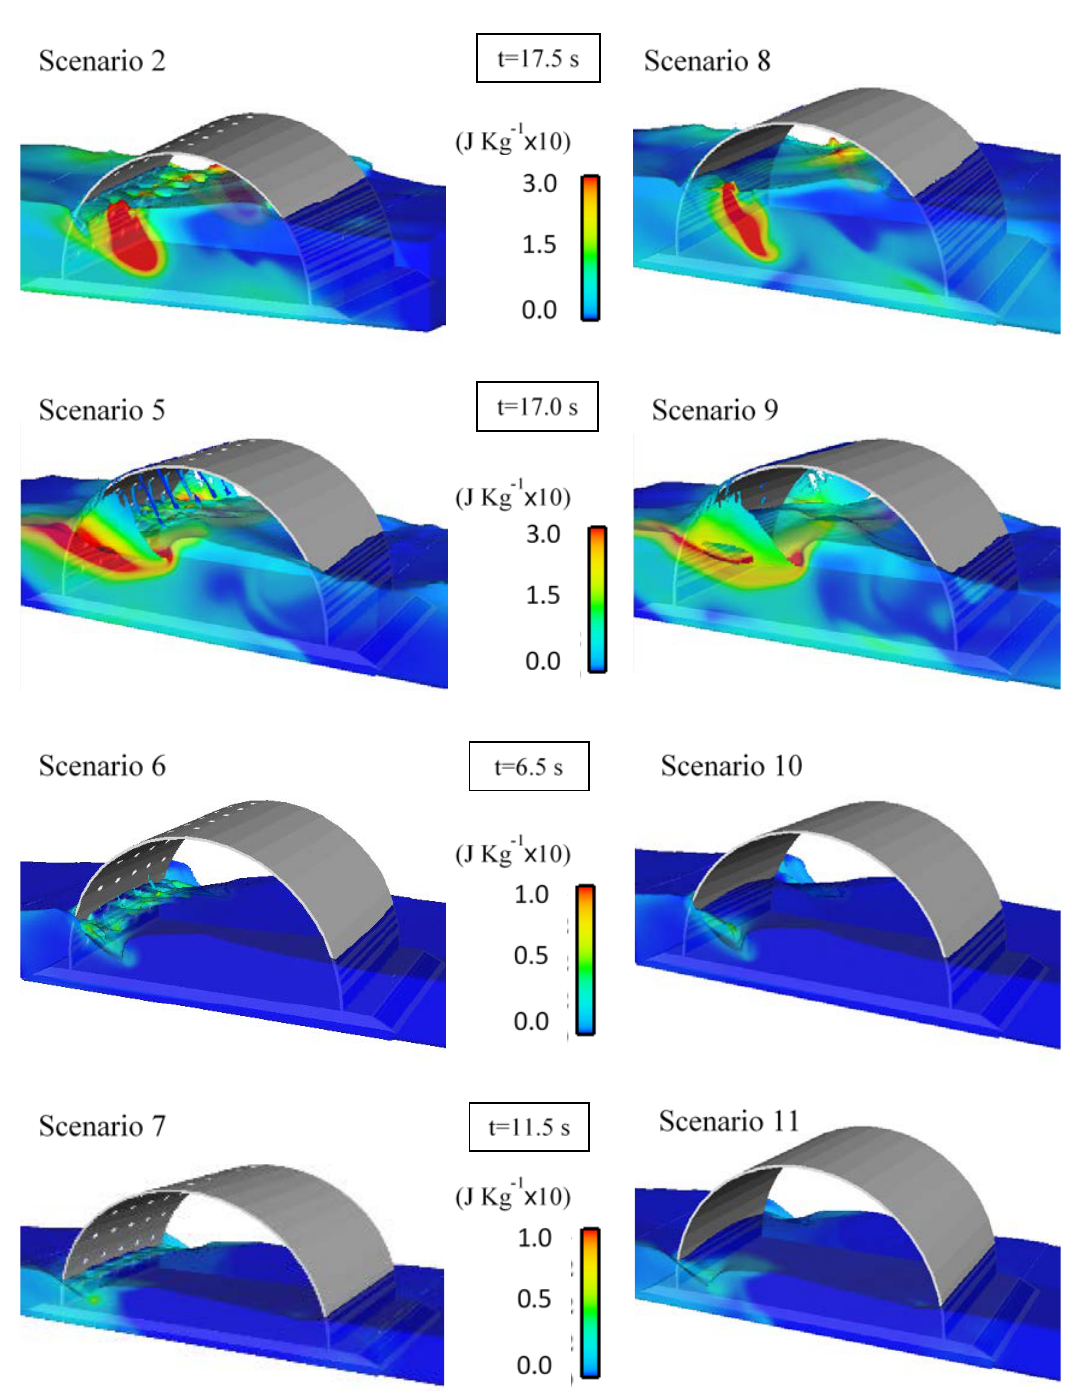
Figure 5. Turbulent kinetic energy: perforated semicircular breakwater (left) and non-perforated semicircular breakwater (right).